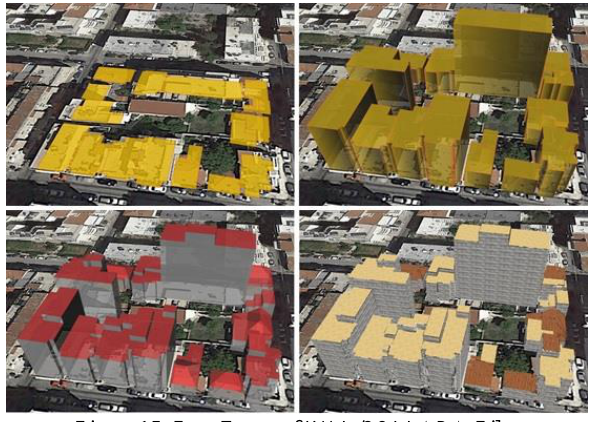
Figure 15. Four Types of KML/COLLADA